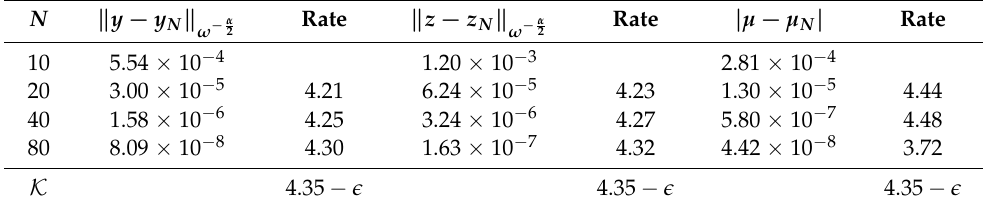
Table 1. Errors and convergence rates of y , z in weighted L 2 norm and µ with α = 1.30.